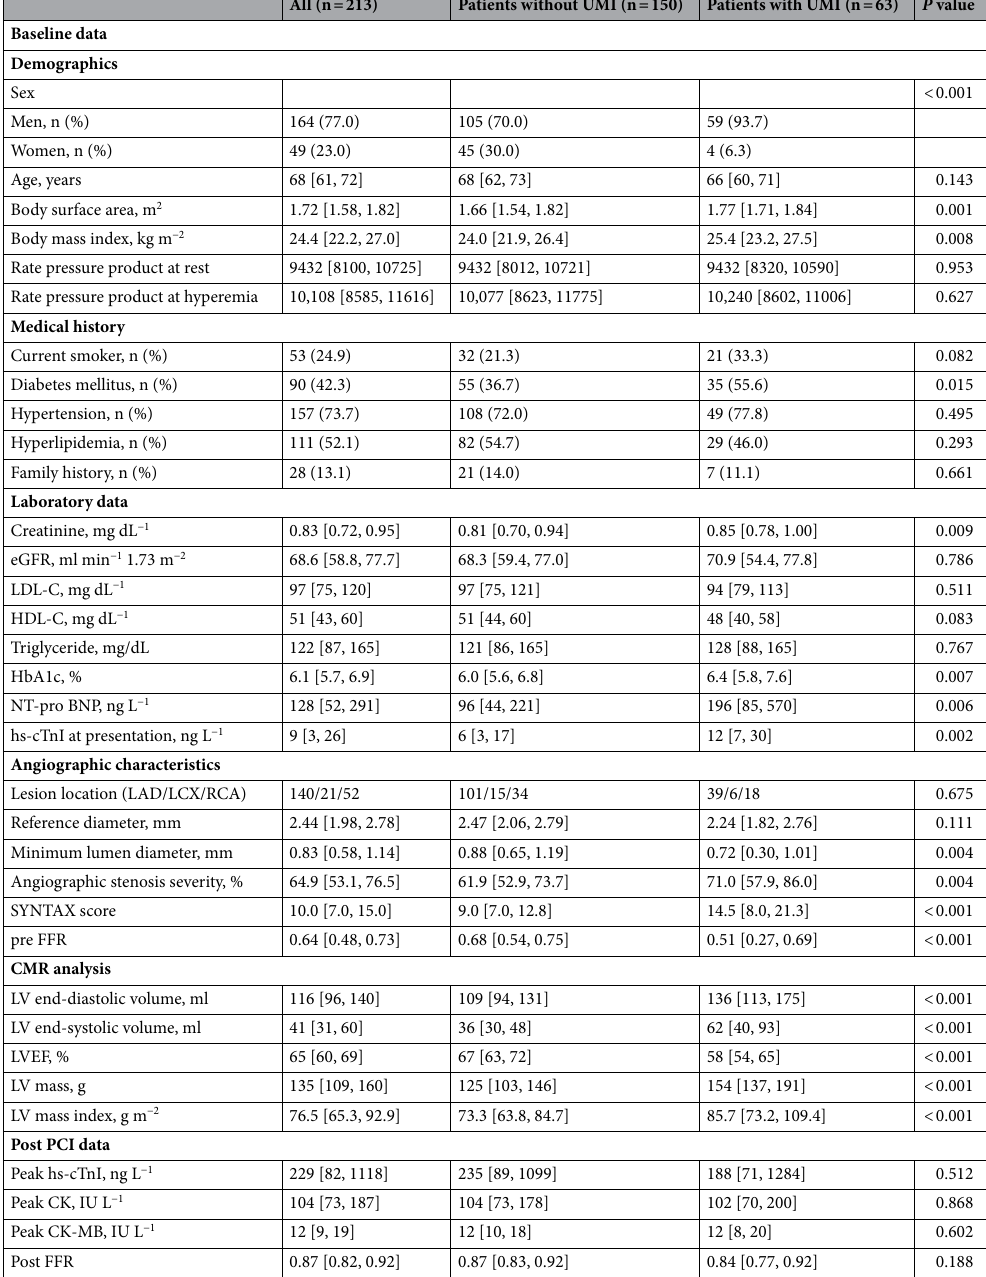
Table 1. Baseline patient characteristics. Data are presented as number (%), median (interquartile range). CK creatine kinase, EF ejection fraction, eGFR estimated glomerular filtration rate, FFR fractional flow reserve, HbA1c glycosylated hemoglobin, HDL‑C high-density lipoprotein cholesterol, hs‑cTnI high-sensitivity cardiac troponin-I, LAD left anterior descending coronary artery, LCx left circumflex coronary artery, LDL‑C low- density lipoprotein cholesterol, LV left ventricular, NT‑proBNP N-terminal pro B-type natriuretic peptide, RCA right coronary artery, UMI unrecognized myocardial